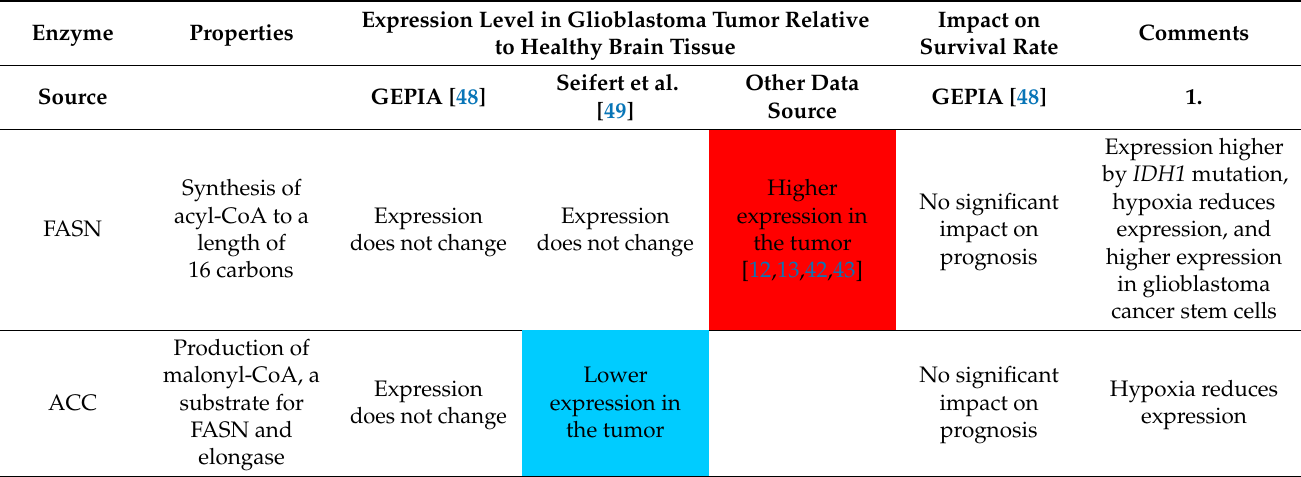
Table 1. Characteristics of FASN and